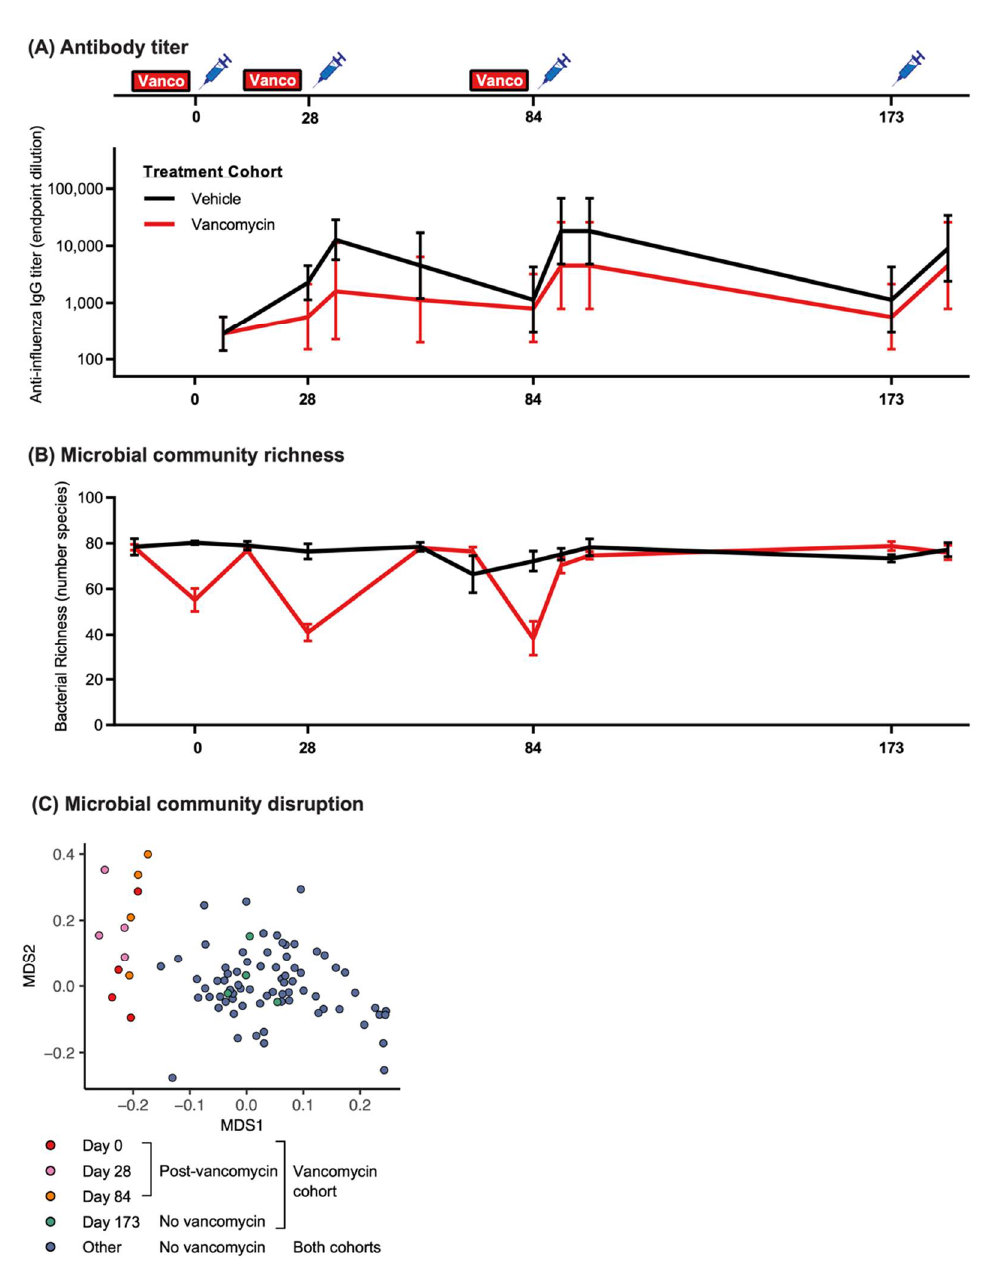
Figure 3. Vancomycin treatment before vaccination reduces influenza-specific antibody titers. ( A ) Rhesus macaques were orally treated with three 14 day courses of vancomycin (red rectangles), followed by one day without vancomycin, before vaccination with quadrivalent influenza vaccine (blue syringes). A fourth vaccination was performed without vancomycin pre-treatment (Day 173). Serum anti-influenza IgG was measured at multiple timepoints. Data are geometric mean and standard deviation. ( B ) Fecal samples collected throughout the study were subjected to 16s rRNA gene sequencing, and OTU richness (alpha diversity) was plotted. Data are mean and standard error. ( C ) Non-metric multidimensional scaling ordination of macaque microbiome communities, with community dissimilarity measured using the Bray–Curtis algorithm (beta-diversity). Samples from the vancomycin cohort taken at the time of vaccination after vancomycin treatment (Days 0, 28, 84) are shown in warm colors, while those taken at vaccination without preceding vancomycin treatment (Day 173) are shown in green. Additional samples from the vancomycin cohort between vaccinations, as well as all samples from the vehicle cohort, are shown in blue and labeled in the key as